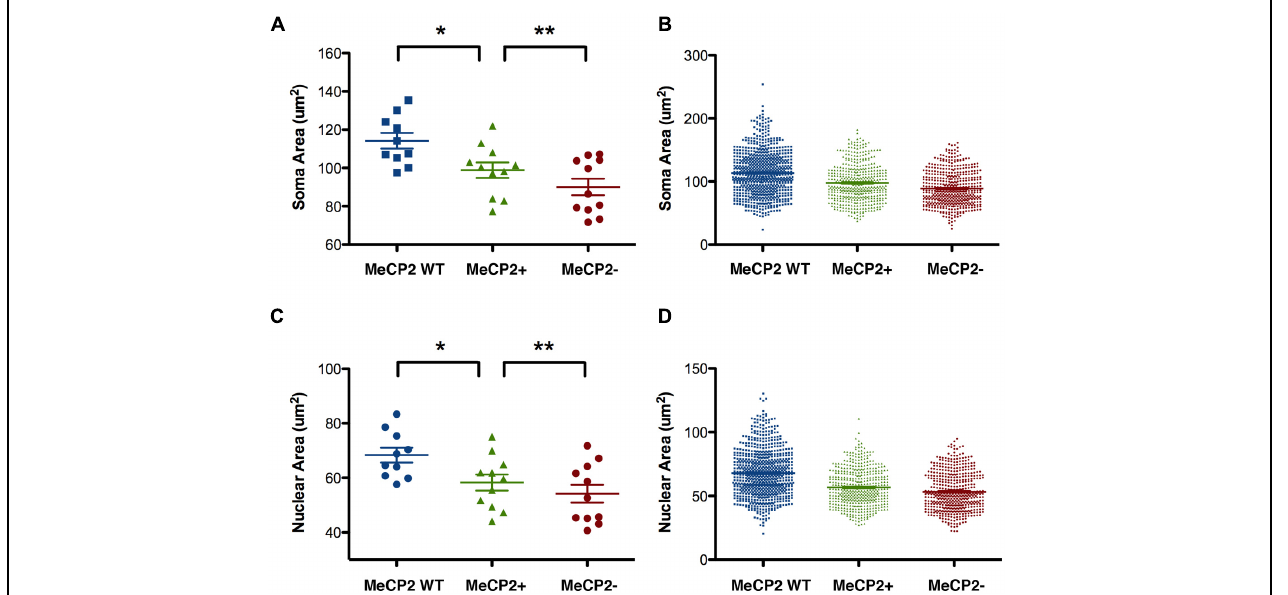
FIGURE 11 | Soma and nuclear size comparison between wild-type and heterozygous females. (A,C) MeCP 2 WT Layer V neurons (wild-type) are larger than MeCP2 + neurons in heterozygous mice, which suggests a non-cell-autonomous effect of MeCP2 deficiency (MeCP 2 WT, n = 10 animals; MeCP2 + , n = 11; MeCP2 − n = 11). (B,D) MeCP2 + and MeCP2 − neuronal